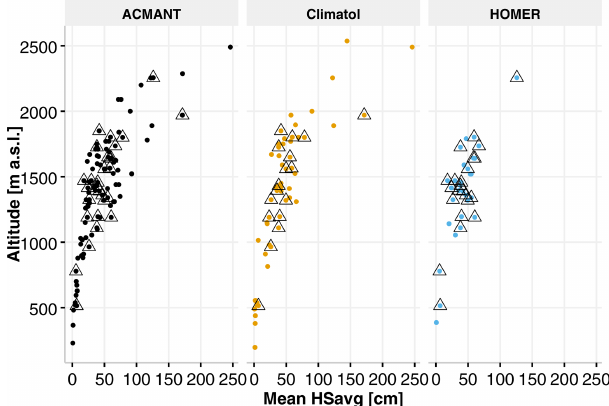
Figure 5. Break points in relation to station altitude and mean HSavg. Valid break points, identified by at least two methods, are marked with black triangles.